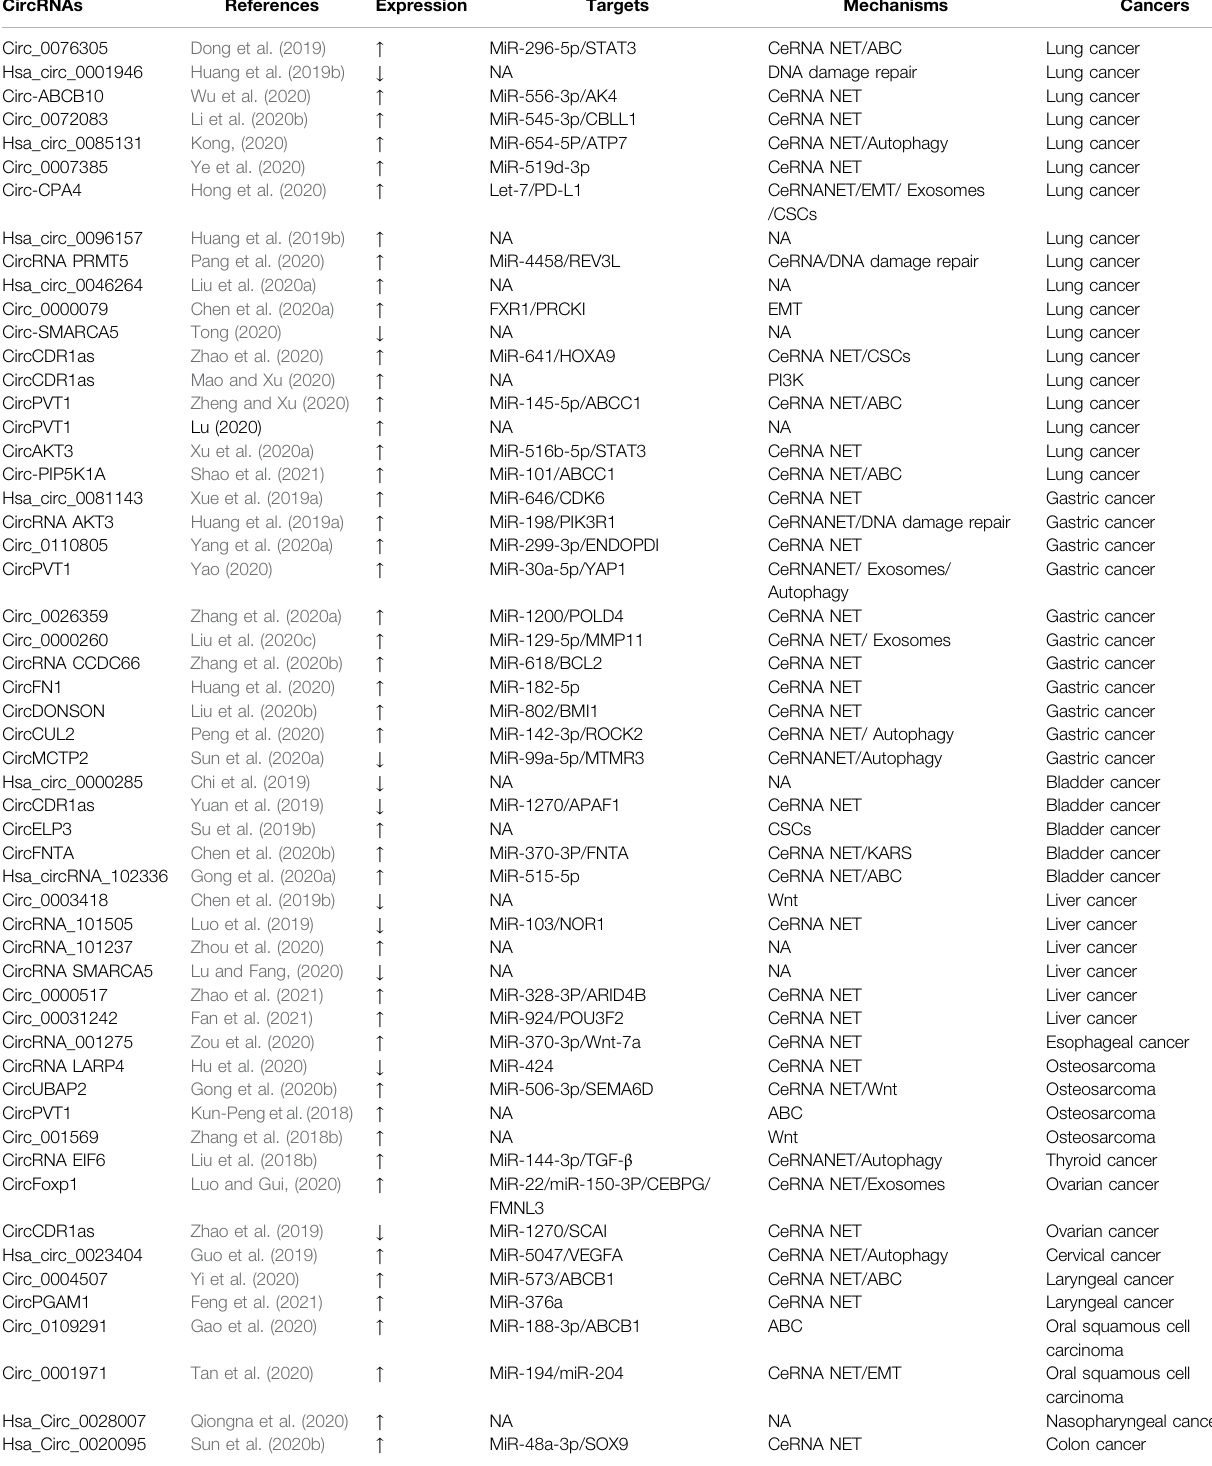
TABLE 1| Collection ofpapersoncircRNAincisplatin resistance. ExpressionreferstothecircRNAexpression incancers.Targetscorrespondtotargeted genesincircRNA downstream. Mechanism denotes the drug resistance mechanism of circRNA in various tumors. NA: not applicable.